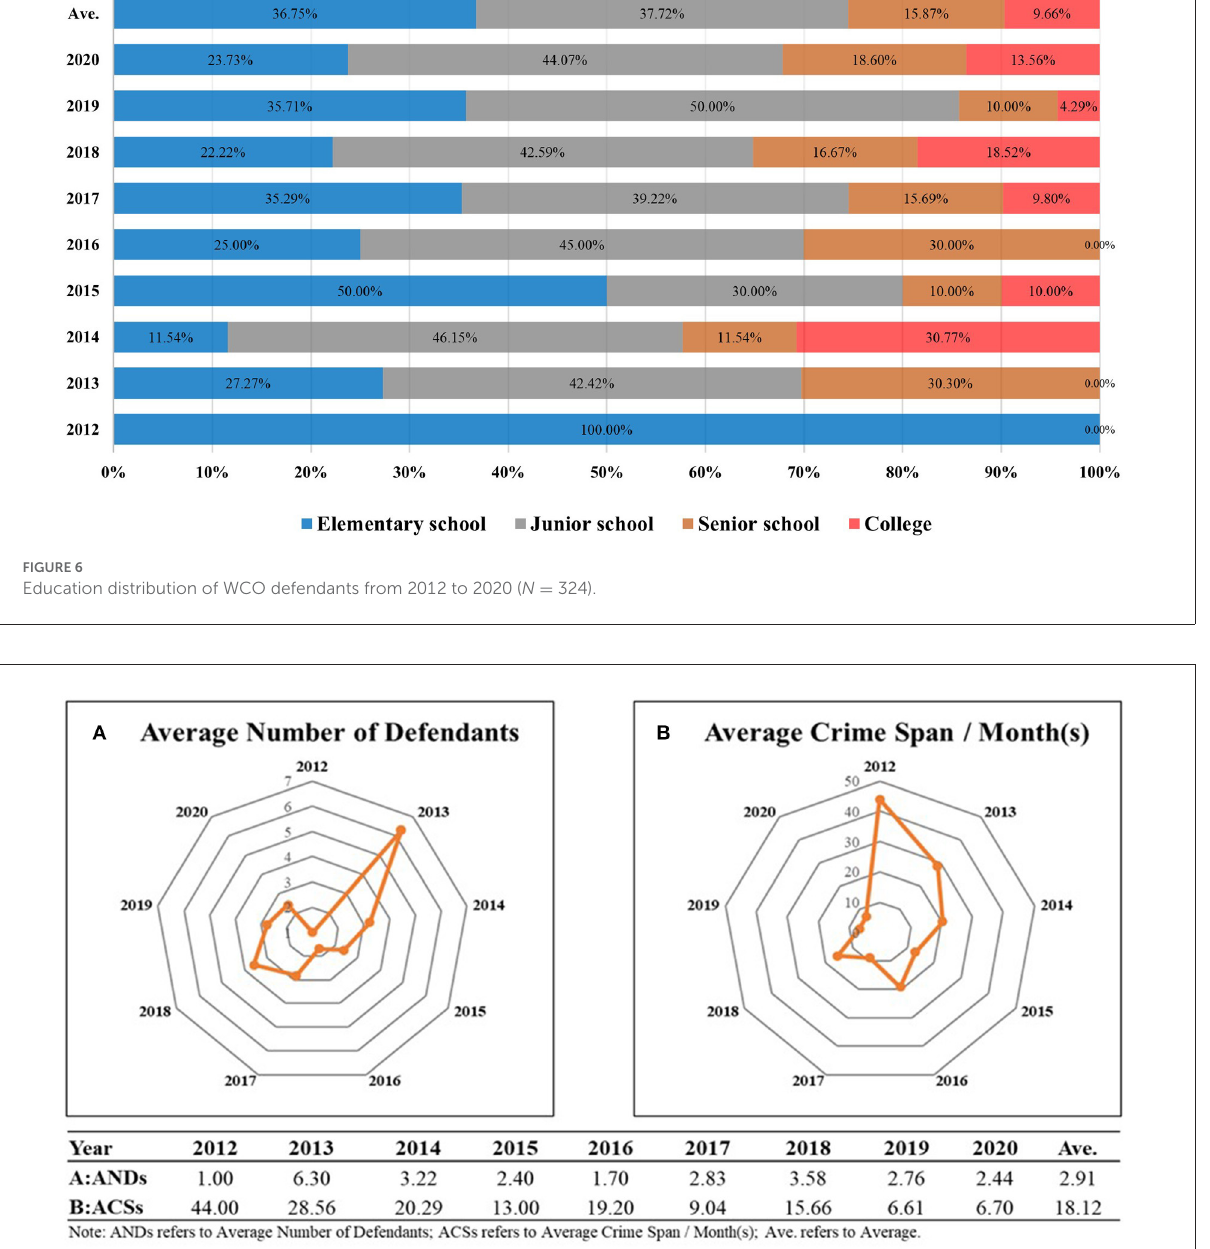
FIGURE7 Average number of (A) defendants in and (B) spans of WCO crimes from 2012 to